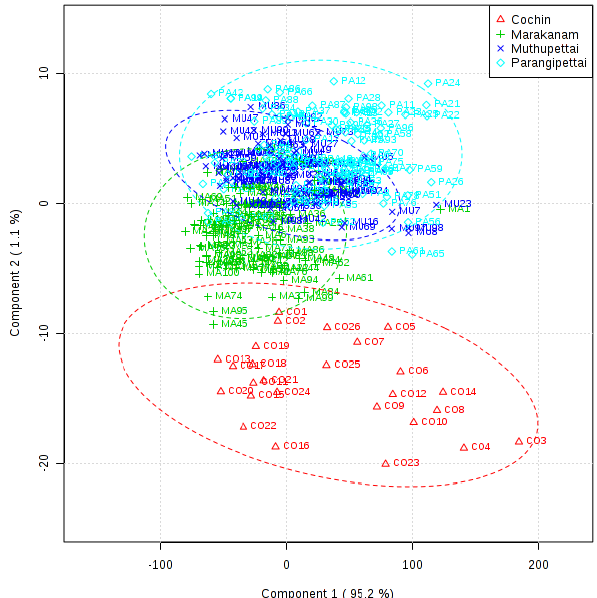
Fig. 3. Plot for first and second principal components in four populations of E.